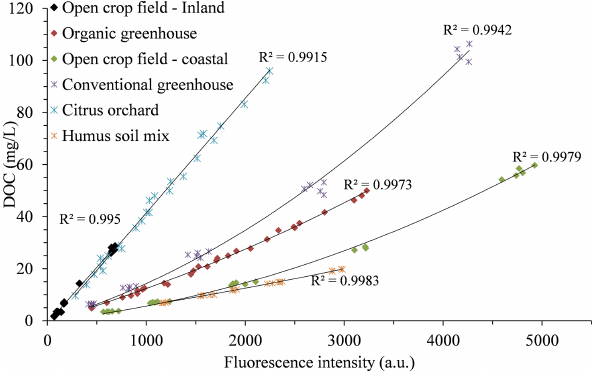
Figure 4. DOC concentration vs. fluorescence intensity at 451nm. Figure 5. Observed vs. predicted nitrate concentrations, for the hu-